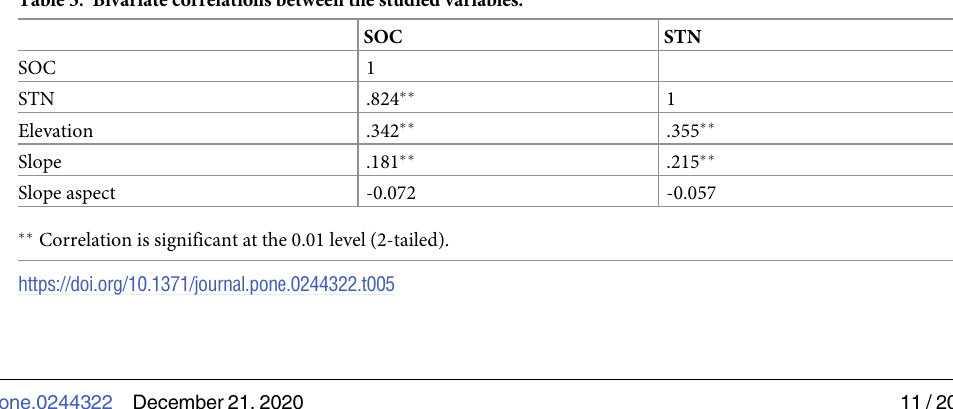
higher than those in sunny slope areas, the results of variance analysis found no statistically significant variations in the SOC and STN concentrations between different slope directions in the study area (F = 0.385, P > 0.05; F = 0.582, P > 0.05). The K–S test indicated that SOC STN all four groups passed the normality test ( P > 0.05). Error bars represent the standard error of the means of SOC and STN at different slope aspects (e.g., sunny, semisunny, semishady and shady slopes). Same letters above columns indicate no significant difference at P > 0.05.